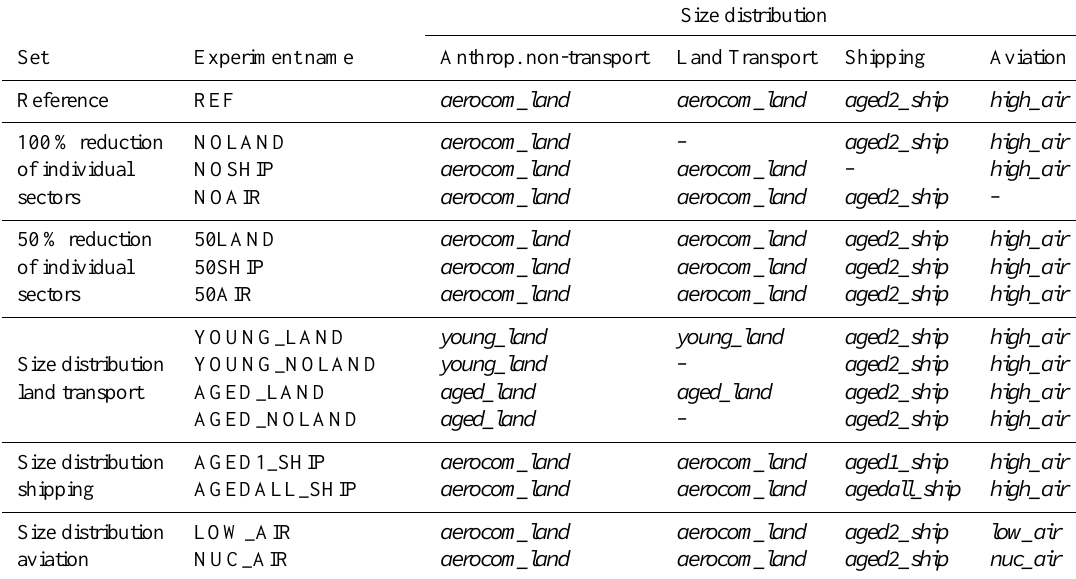
Table 2. Summary of the simulations performed in this work, with the corresponding assumptions for emissions and particle size distri- butions. Since the reference simulation (REF) considers the aerocom_land , aged2_ship and high_air size distributions (for land transport, shipping and aviation, respectively), this experiment is also referred to as AEROCOM_LAND, AGED2_SHIP or HIGH_AIR in the text when referring to the specific sector. For the details about each size distribution see Appendix